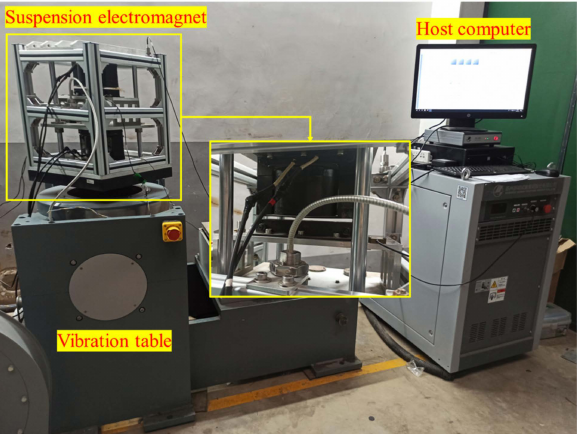
Figure 15. Schematic diagram of suspension electromagnet module of magnetic suspension system experimental